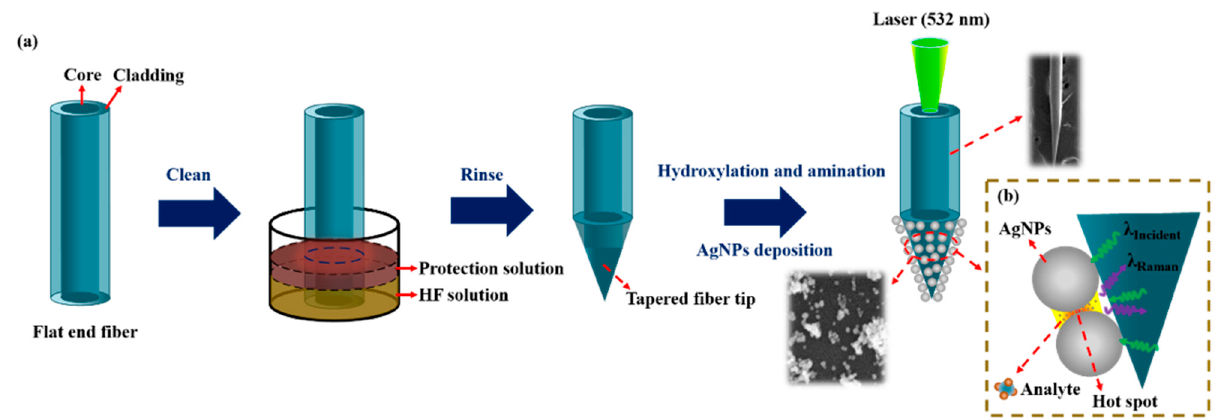
Figure 1. Schematic illustration of ( a ) the fabrication process of the tapered fiber and ( b ) Raman detection.